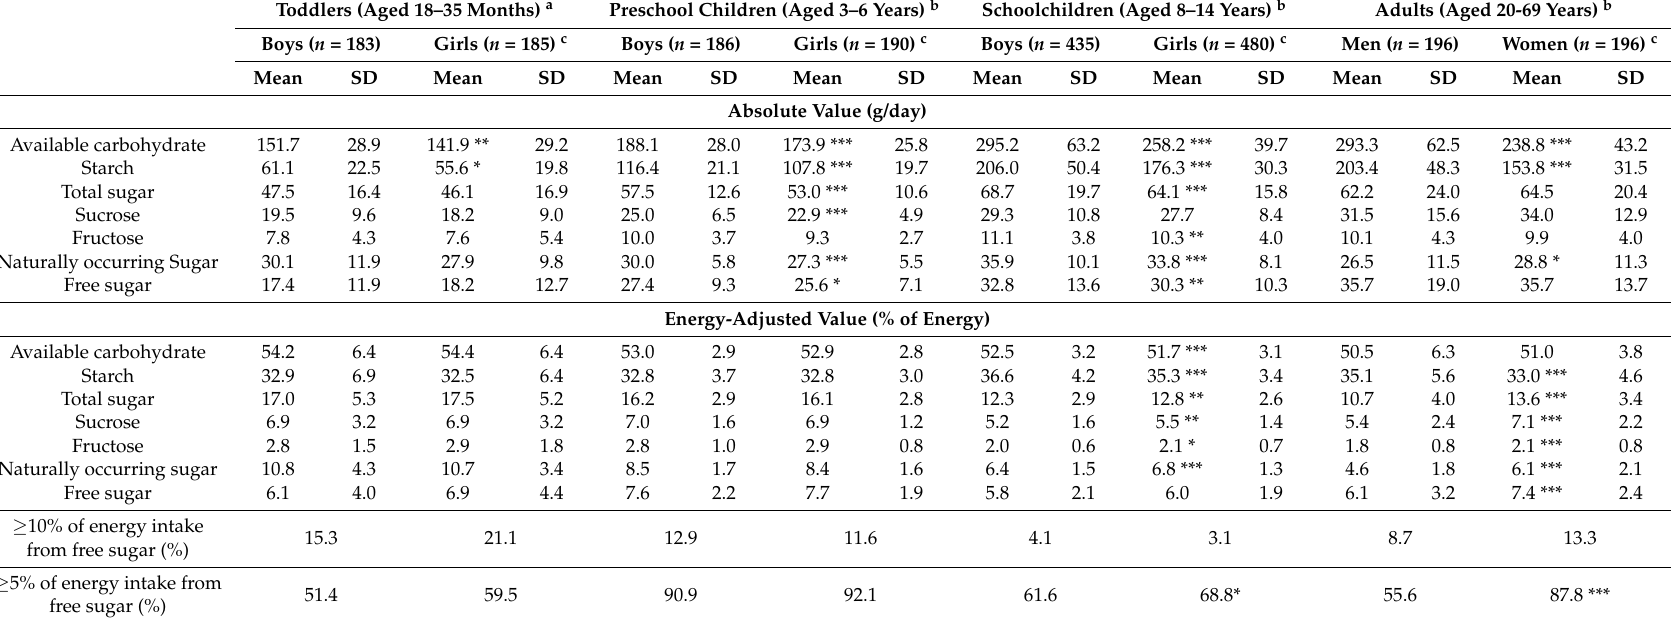
Table 2. Estimated intakes of available carbohydrate, starch, total sugar, sucrose, fructose, naturally occurring sugar and free sugar in Japanese children and